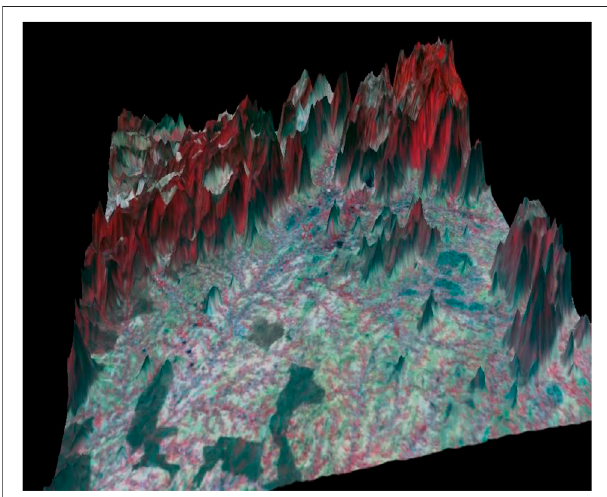
FIGURE 9 | Digital elevation model of the Vanniyar basin, Dharmapuri district, Tamil Nadu, India.